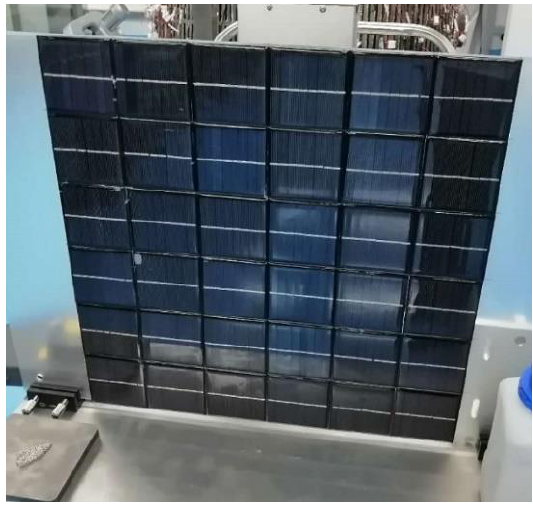
Figure 8. The spliced photovoltaic panels. The open circuit voltage of each cell in the photovoltaic panel shown in Figure 8 is 0.6 V and the short circuit current is 120 mA (1000 W/m 2 standard light intensity). The 36 photovoltaic cells of the photovoltaic panel are divided into 9 branches. They are connected in parallel to form the total output of the whole photovoltaic panel. Each branch is composed of four photovoltaic cells in series. The circuit diagram is shown in Figure 9. When the above circuit connections are changed, the output voltage and current of the photovoltaic panel will be changed. However, since the comparison experiment only needs to be carried out under the same circuit connection, the relationship between the circuit connection and output will not be discussed in